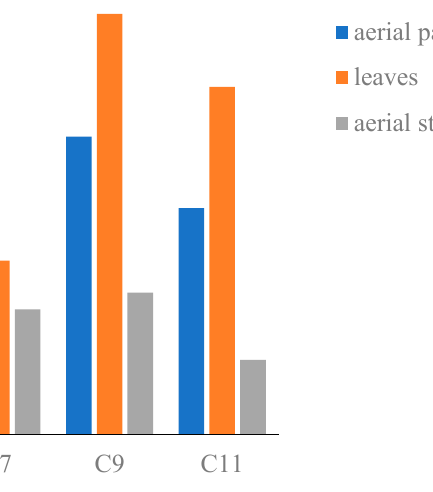
Figure 2. Bar graph of content of six alkaloids in dried Houttuyniae herba. The total content of six alkaloids in fresh Houttuyniae herba (Figure 3) (calculated as dry) was as follows: underground stem (6.5–19 µ g/g) and whole grass (110–130 µ g/g), respectively. The underground stem has a lower potential risk (see Table